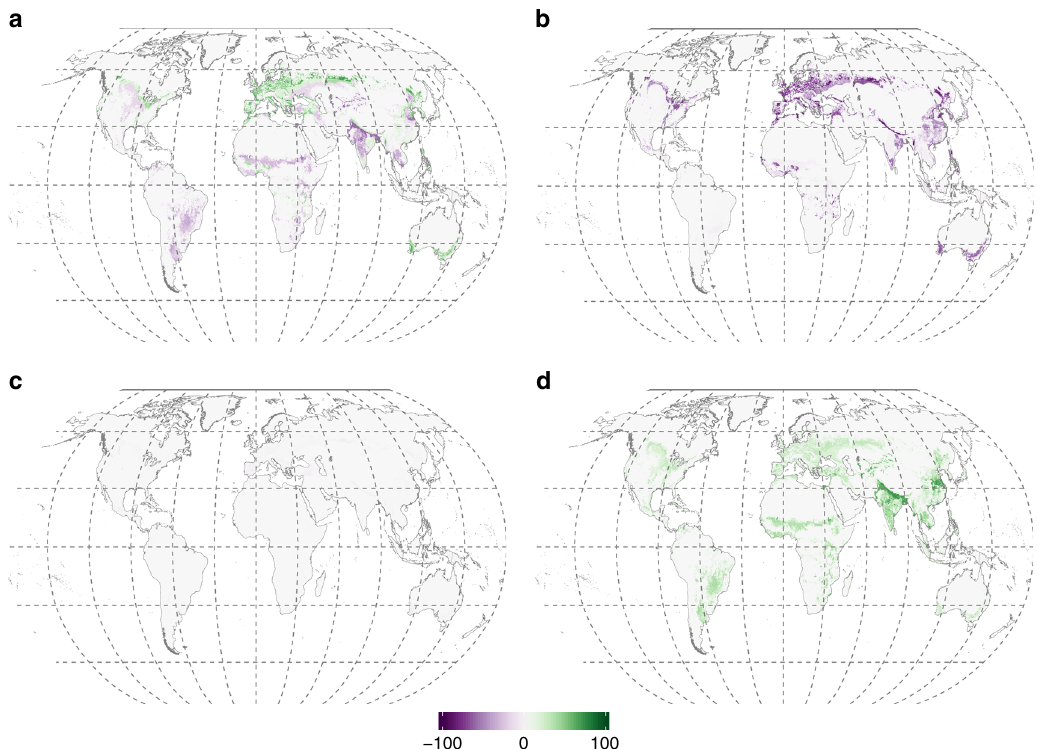
Fig. 3 Changes in biomass fractions of mycorrhizal vegetation induced by crop cultivation and pastures. a Arbuscular mycorrhizal plants, b ectomycorrhizal plants, c ericoid mycorrhizal plants, d non-mycorrhizal plants. Purple colours indicate losses, green colours indicate gains. Uncertainties are shown in Supplementary Fig. 7. Source data are provided as a Source Data fi